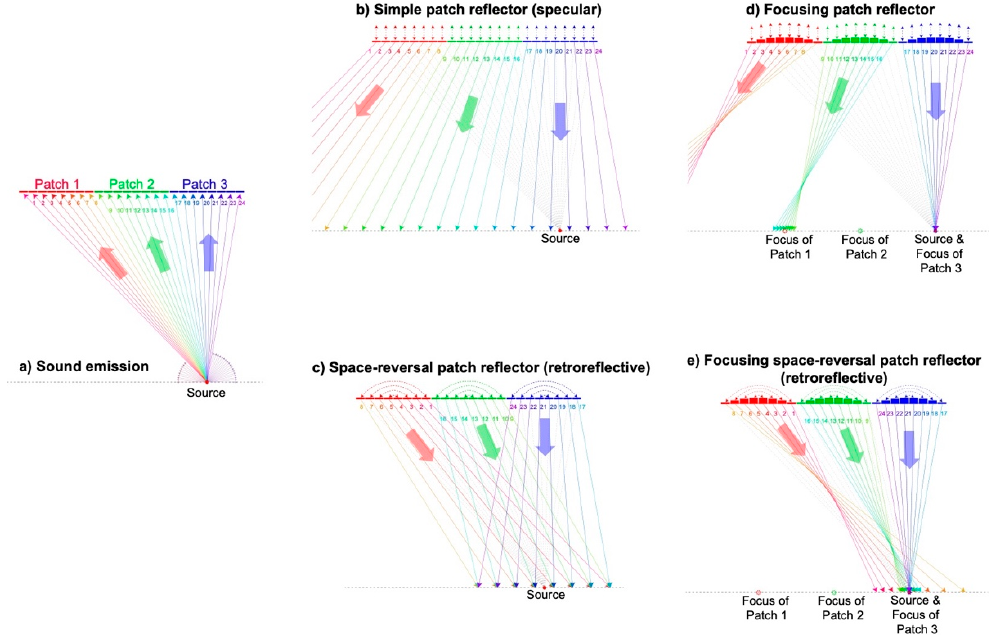
Figure 3. Concepts illustrated by ray analogy in modelling reflections from a flat surface made up of patches, each of which is made up of numerous elements: ( a ) sound is emitted by a source and received by elements; ( b ) if no processing is done, the re-emitted sound from the elements behaves as a specular reflection; ( c ) space-reversal of elements in each patch introduces retroreflection, superimposing the projected images of the patches, with the source at their centres; ( d ) elementwise delays introduce focusing (in this example the source is at the focus of Patch 3); ( e ) the combination of focusing and space-reversal is retroreflective, with a potentially high concentration of reflected rays at and near the source. The ray illustration neglects wave phenomena such as diffraction and